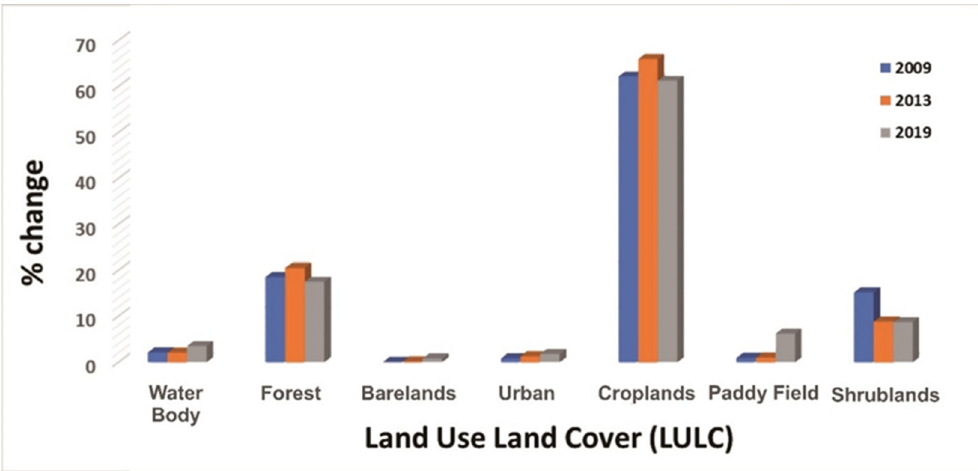
Figure 5. Results of land use analysis for the Krueng Teunom watershed in 2009, 2013, and 2019.